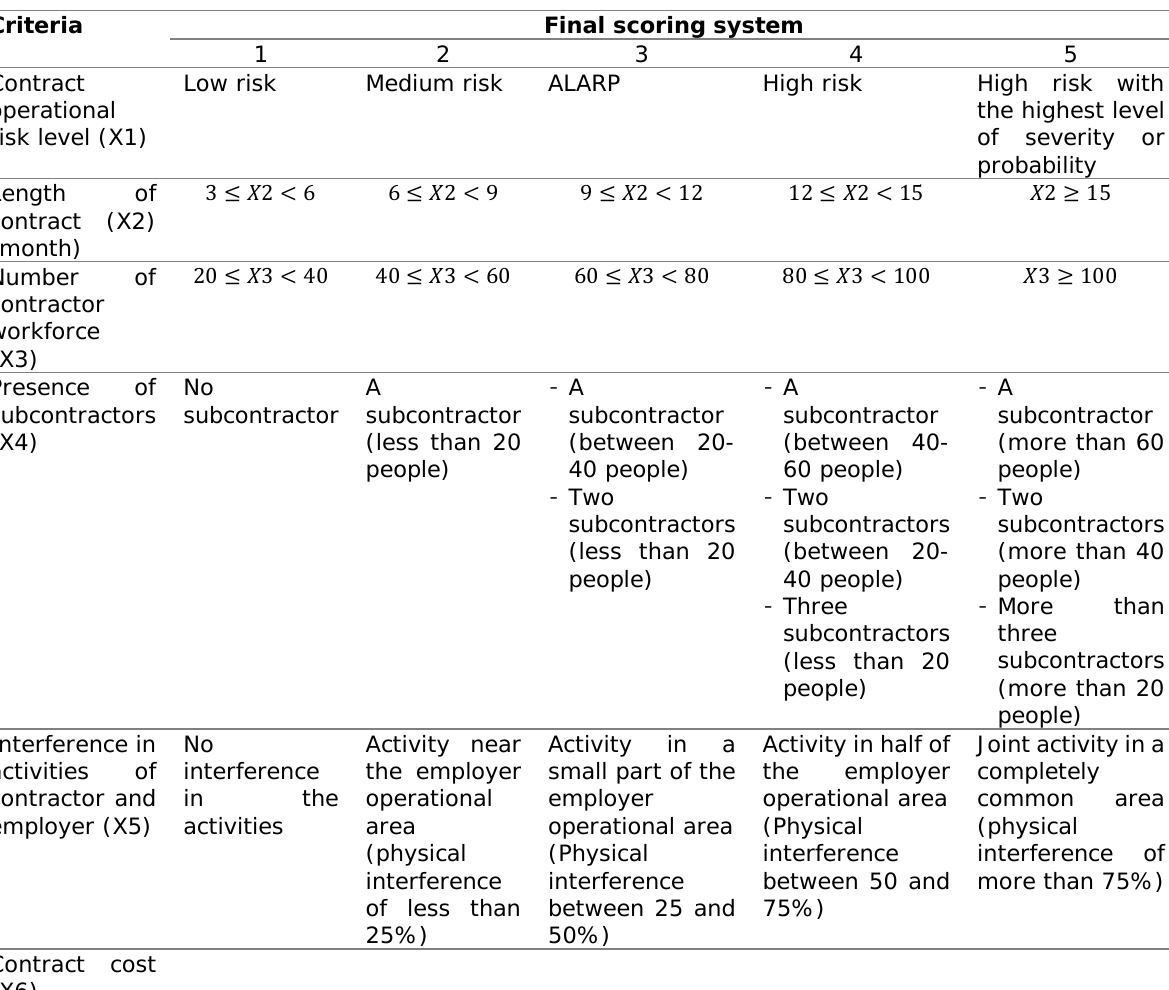
Table 5. Scoring the criteria of contractors HSE pre-qualification